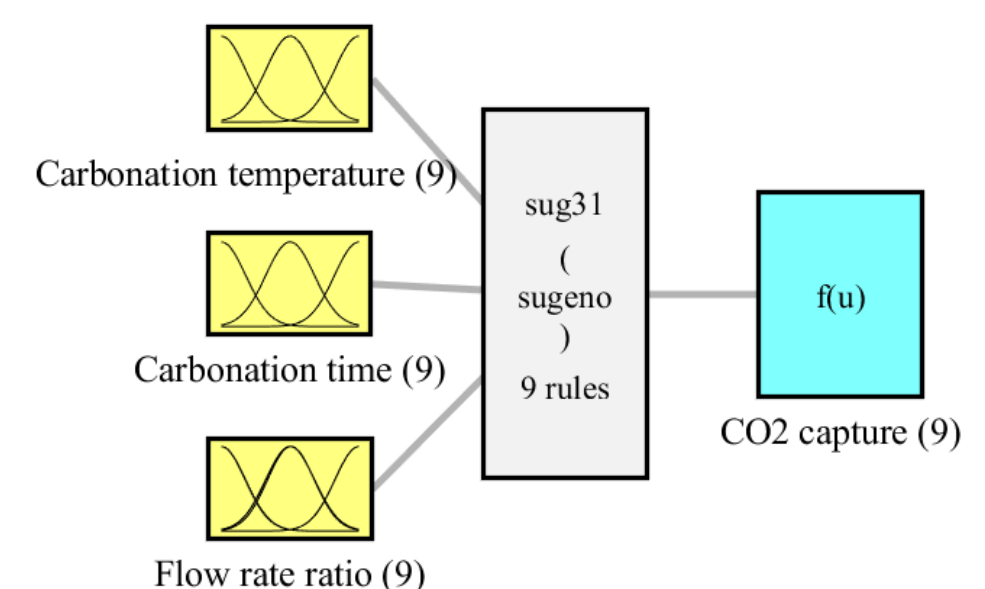
Figure 2. Configuration of the fuzzy model of the CO 2 capture process.